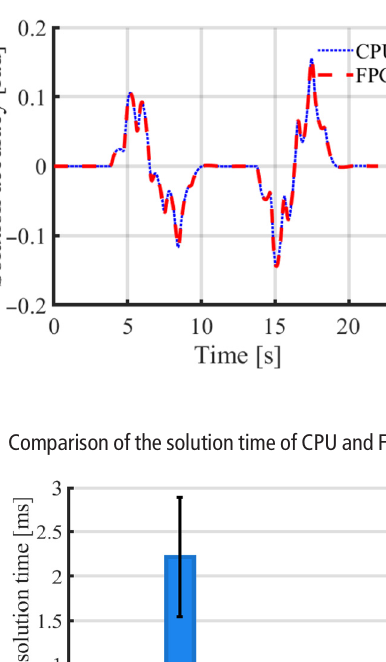
Figure 9 Comparison of the solution accuracy of CPU and FPGA